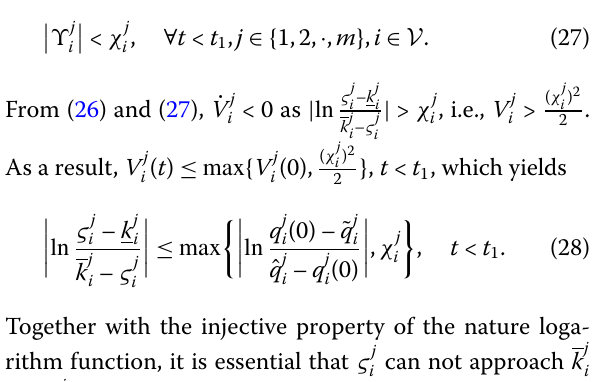
˙ ˙ j k j k , ς j , , and (cid:10) < k i i i i